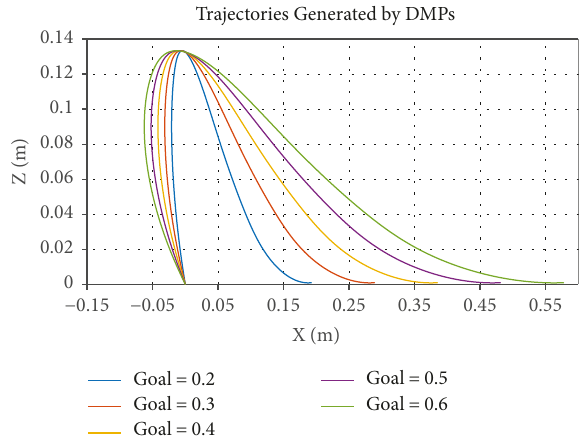
Figure 4: DMPs of foot trajectories with di ff erent parameters S ,